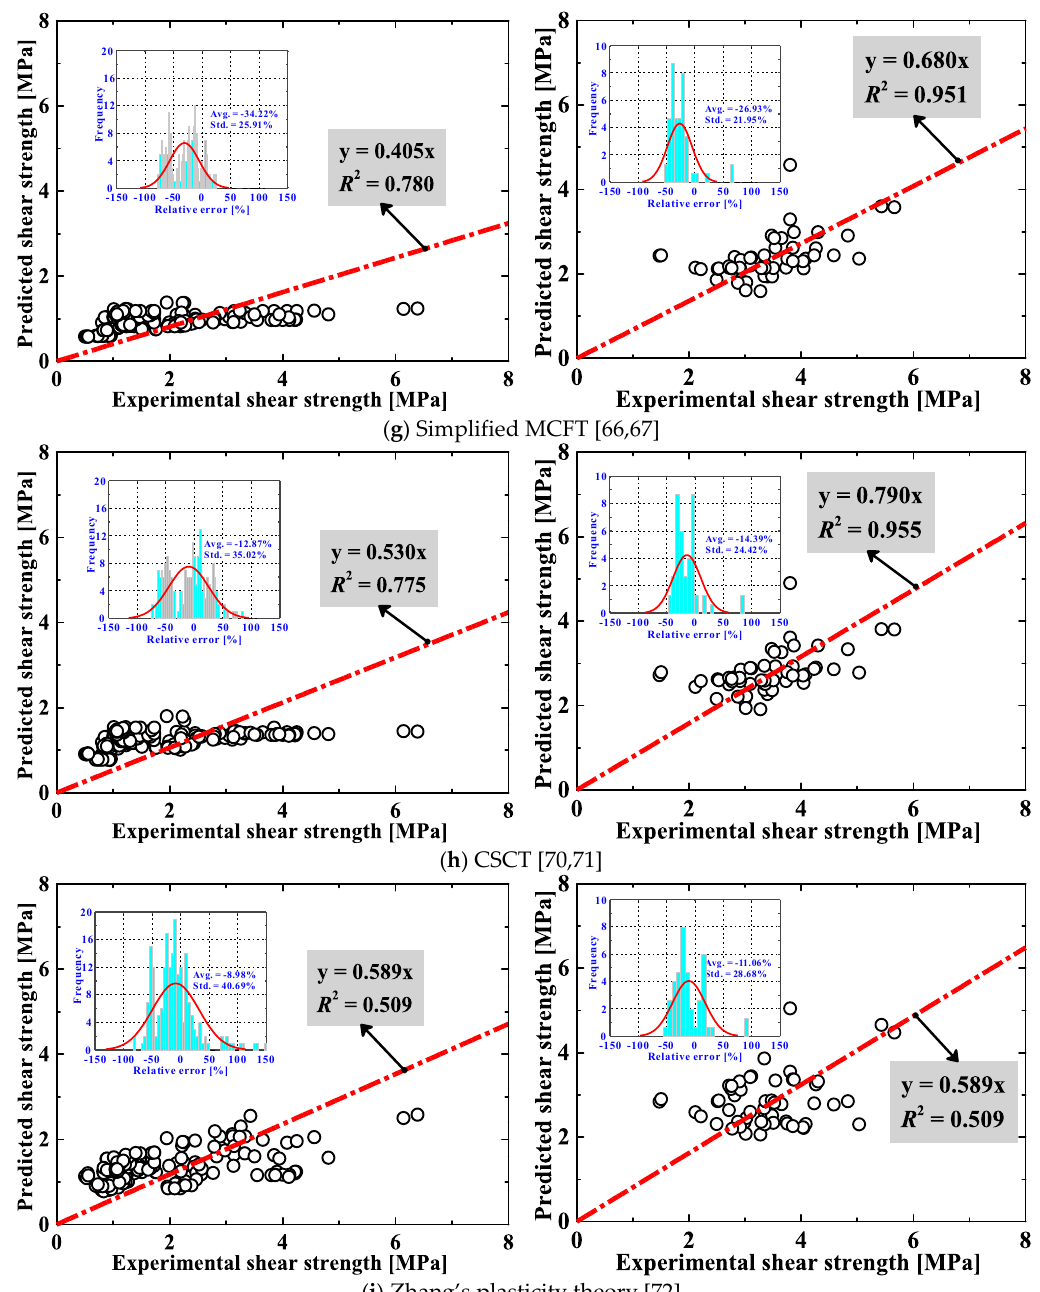
Figure 1. Comparison between predicted and experimental shear strengths for different methods (Left column: beams without stirrups; Right column: beams with stirrups).